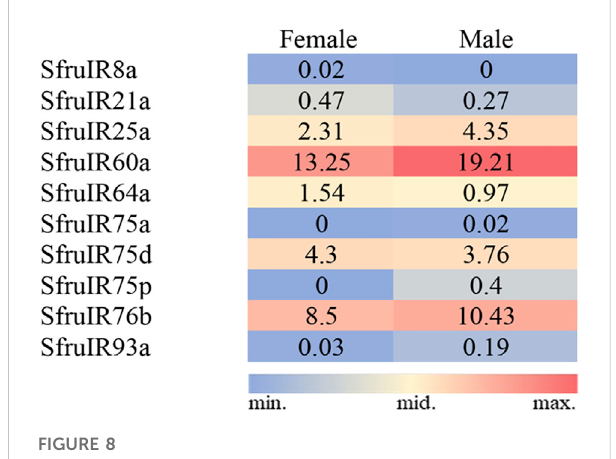
FIGURE 8 TPM values of candidate SfruIRs in the tarsi of male and female S . frugiperda .